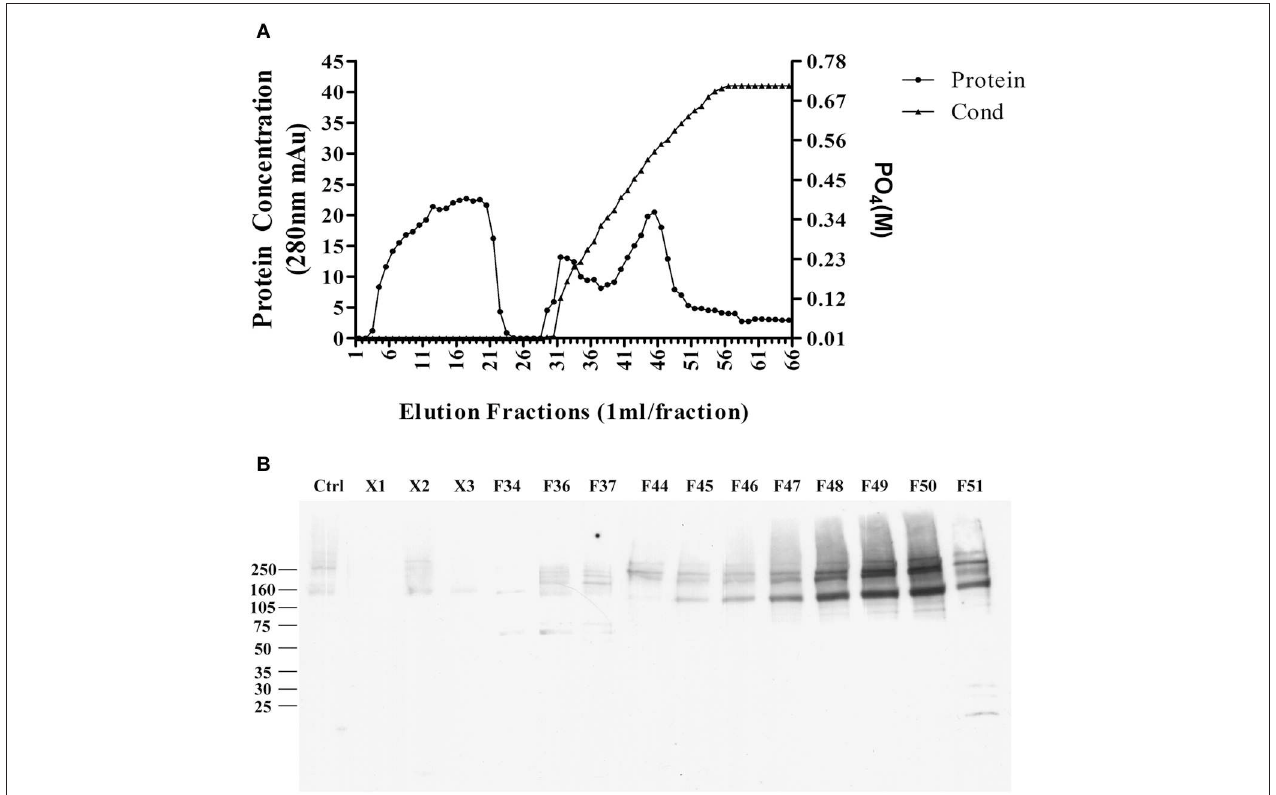
FIGURE 4 | Enrichment of A β O binding proteins p140 and p260 by SDS extraction and CHT Cartridge HPLC. Zwittergent-extracted membrane pellet containing p140 and p260 (see Figure 3 ) was dissolved in SDS and centrifuged at 100,000g × 1h. The supernatant was filterd and applied to a CHT-column. Proteins were eluted by a linear gradient sodium phosphate (10–700mM). (A) Protein concentration profile from column. X1, X2, and X3 were fractions that did not bind to the column. (B) A β O ligand blots of eluted fractions. Fractions F49 and F50 were found to contain p140 and p260 proteins. These fractions were dialyzed, and concentrated by for LC-MS/MS. TABLE 1 | Proteins were identified for p260, p140, and p100 from LC-MS/MS data. Protein fractions Protein Gi